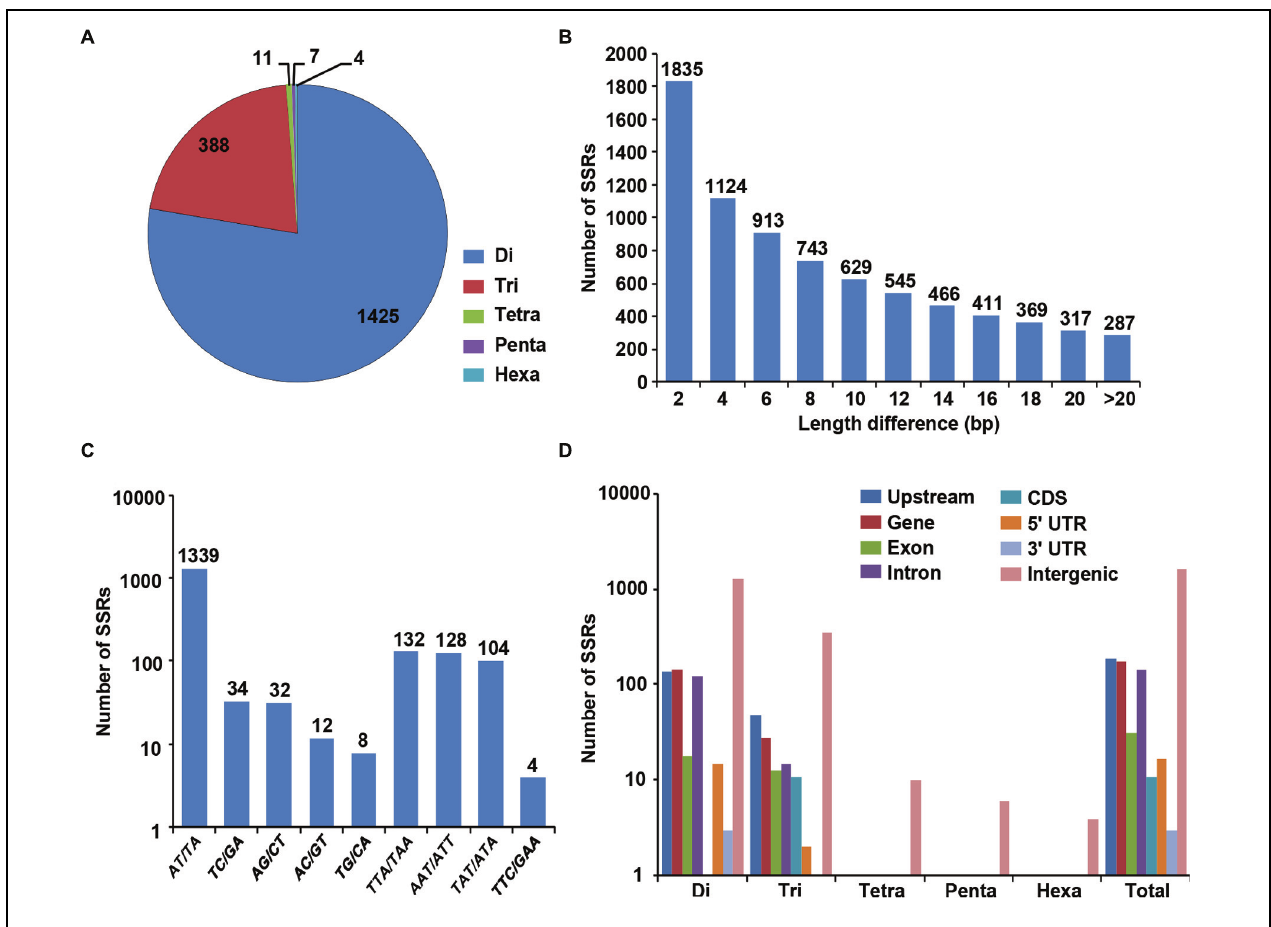
FIGURE 3 | Identification and analysis of polymorphic SSRs between desi and kabuli chickpea. (A) Distribution of polymorphic SSRs in different classes. (B) Number of SSRs with different motif length (2 to > 20) differences.